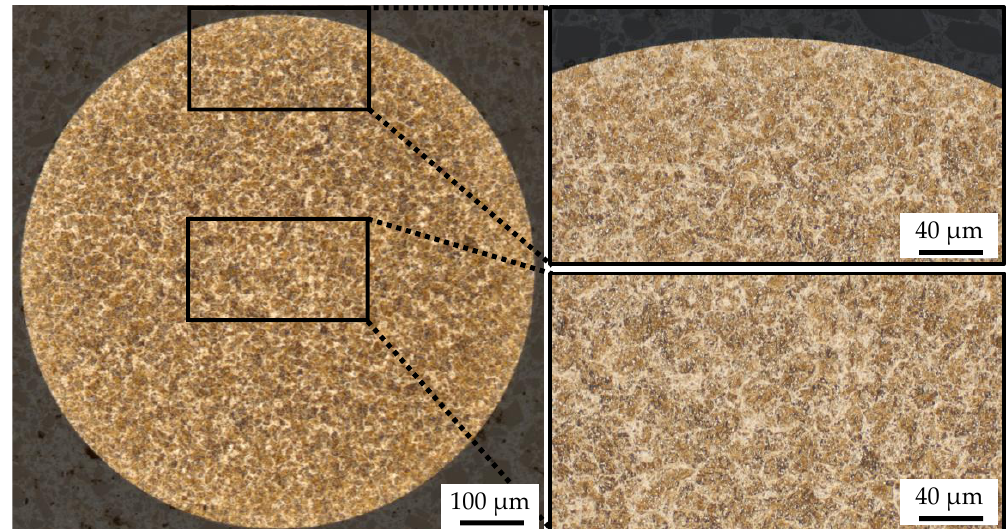
Figure 1. Microstructure of the microsamples after the roller ball production process; etched 25–30 s in 3% alcoholic HNO 3 , equatorial cut.